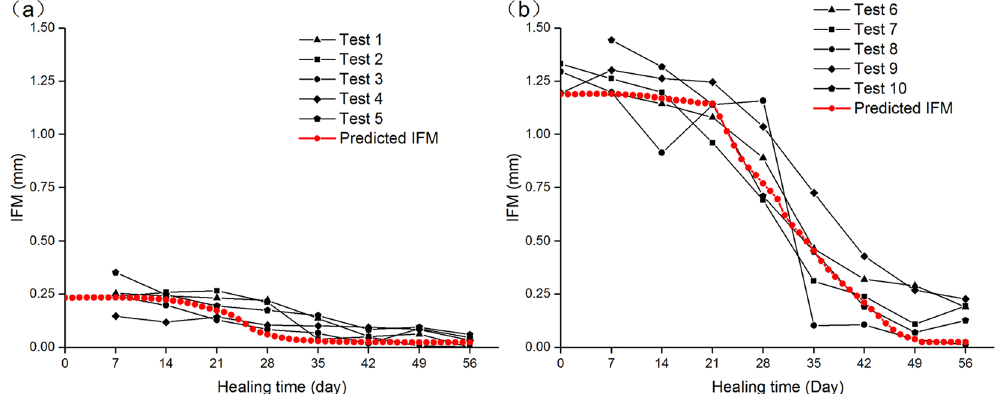
Figure 3. ( a ) Predicted IFM over time of case A and weekly measured IFM from experiments conducted by Claes et al . 29 . ( b ) Predicted IFM over time of case B and weekly measured IFM from experiments conducted by Claes et al . 29